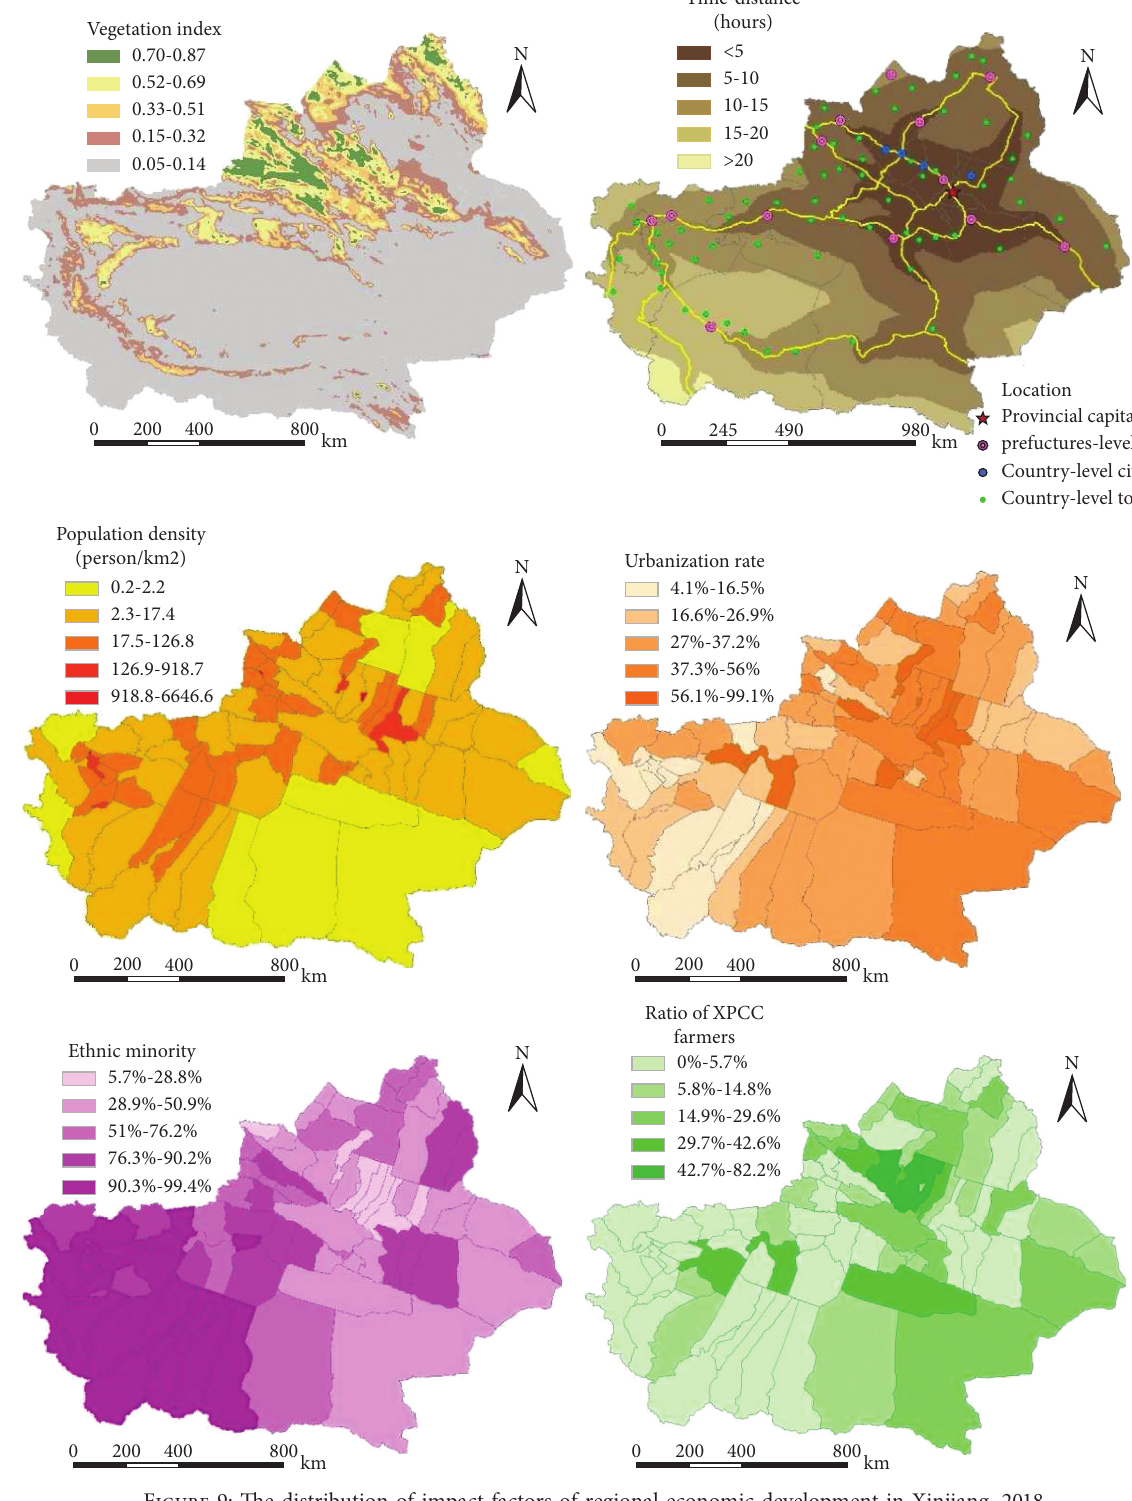
Figure 9: The distribution of impact factors of regional economic development in Xinjiang,